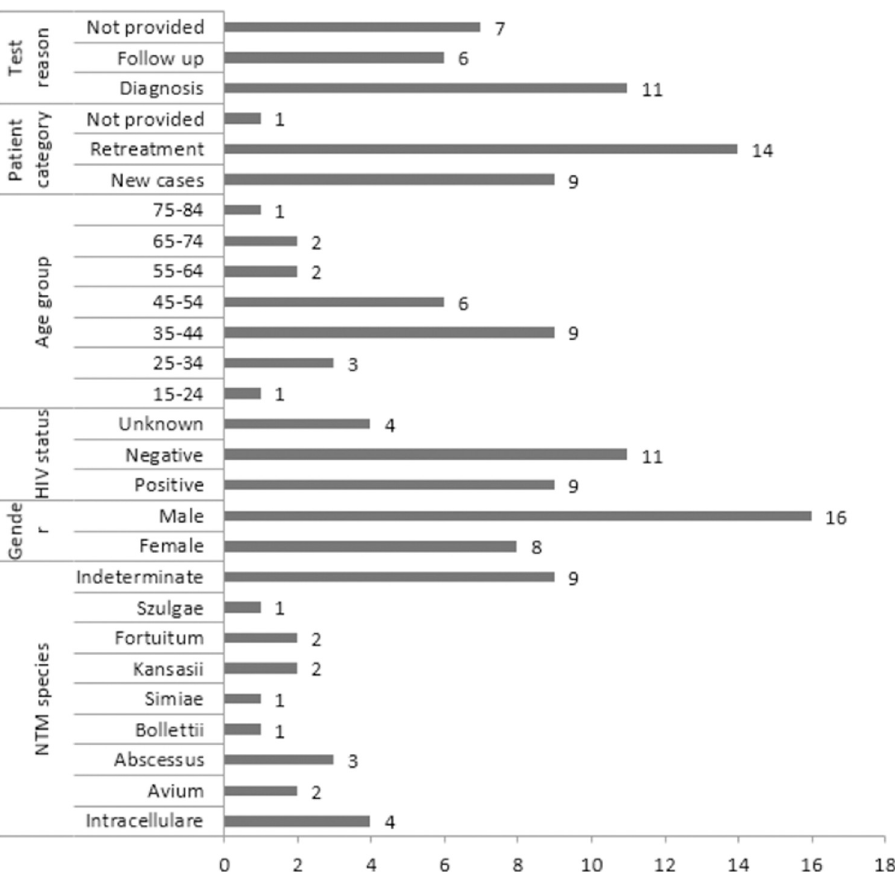
Fig 2. Factors associated with Non-tuberculous mycobacteria among patients with pulmonary TB.